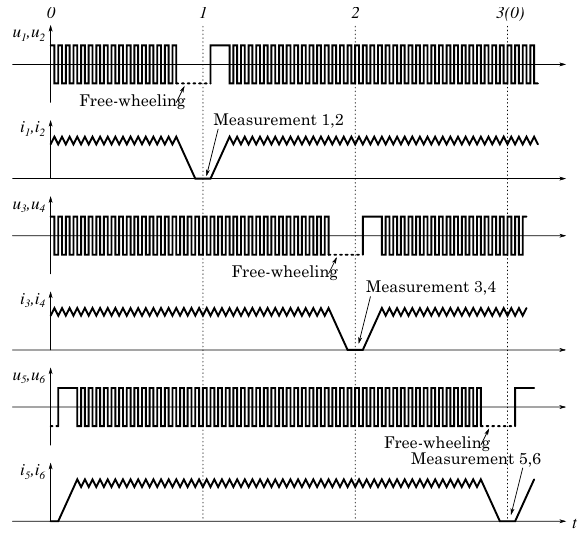
Figure 8. PWM switching pattern for position measurement, show- ing voltage and current in the six actuator